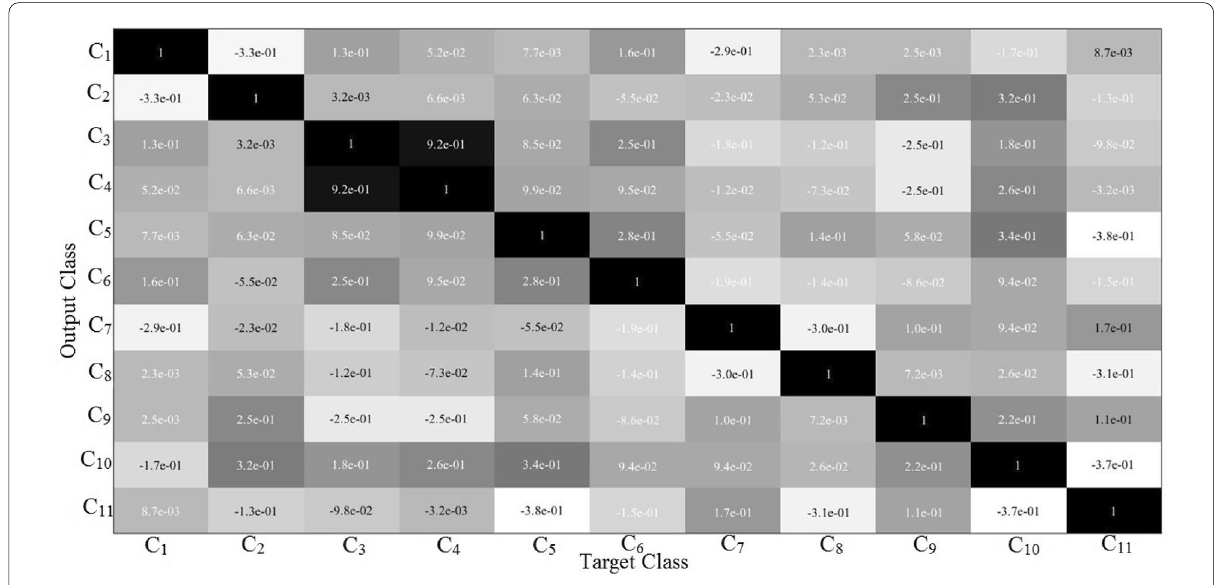
Fig. 19 Relationships between the input parameters and output parameter.